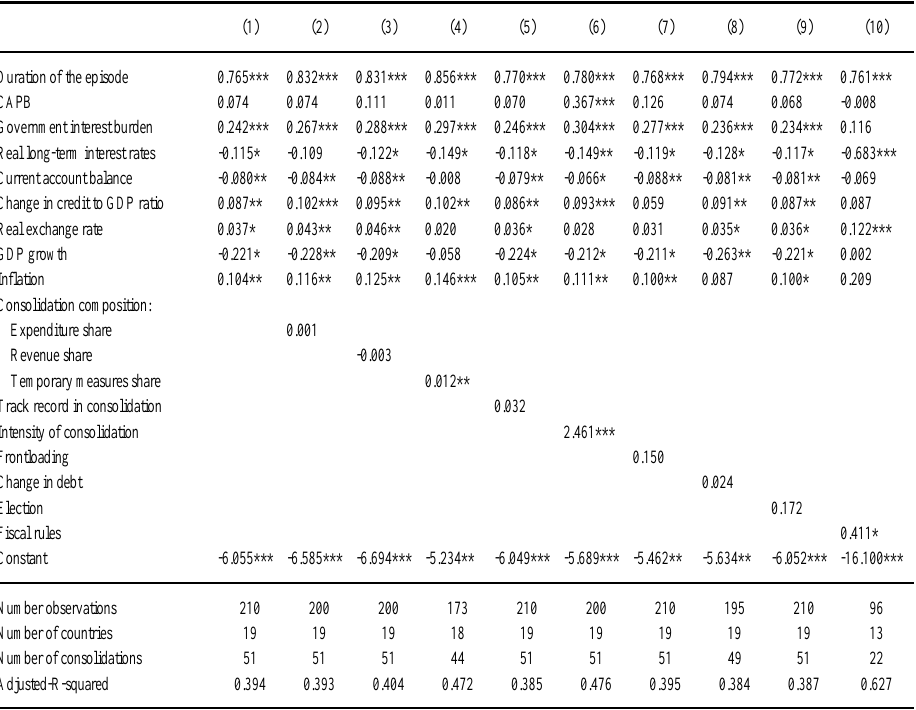
Table 6: Determinants of duration of consolidations – fiscal policy and the fiscal framework (estimates of hazard function using Weibull model, coefficients shown as hazard